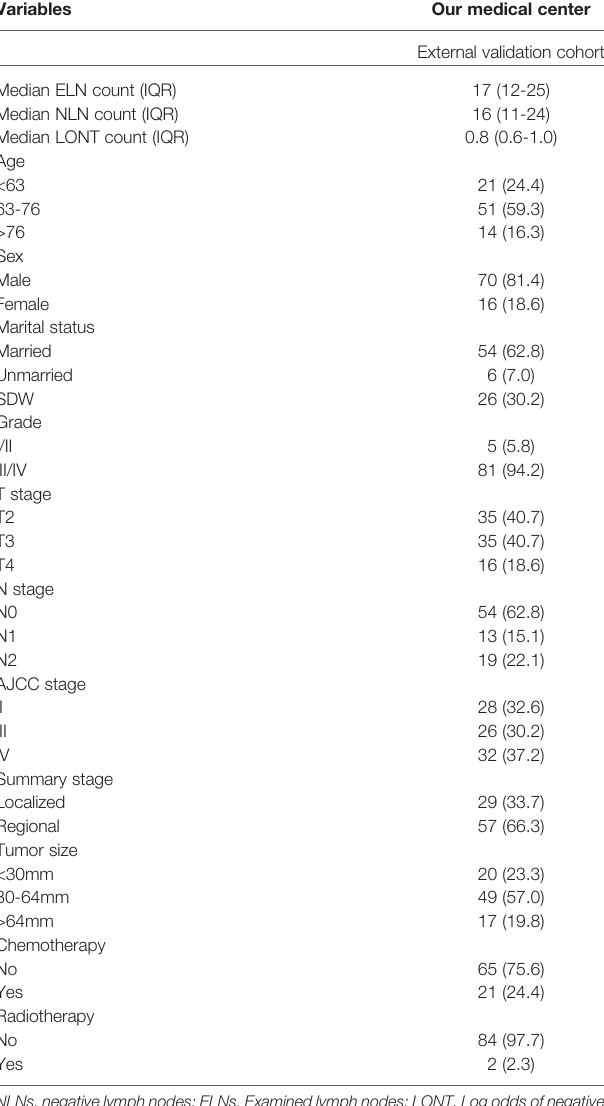
TABLE 2 | Demographics and clinical characteristics of the 86 BLCA patients from our medical center. Variables Our medical